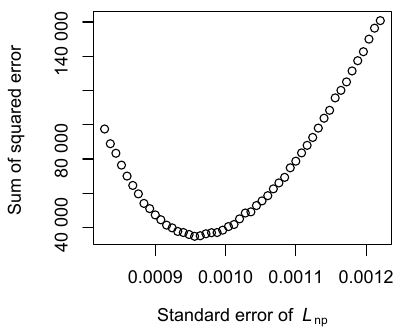
Figure 4. Sum of squared error as a function of standard error ( s) of the original sensor noise. The minimum error is achieved when s = 0 .